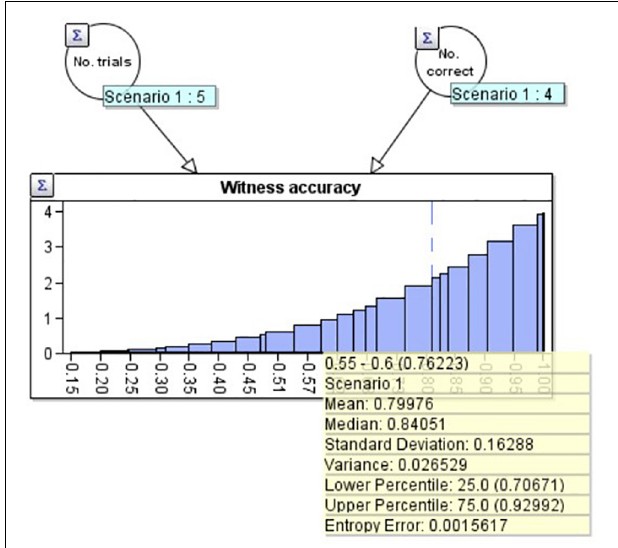
FIGURE 1 | A beta distribution with mean 80.0% and standard deviation 16.3% created using the Agenarisk